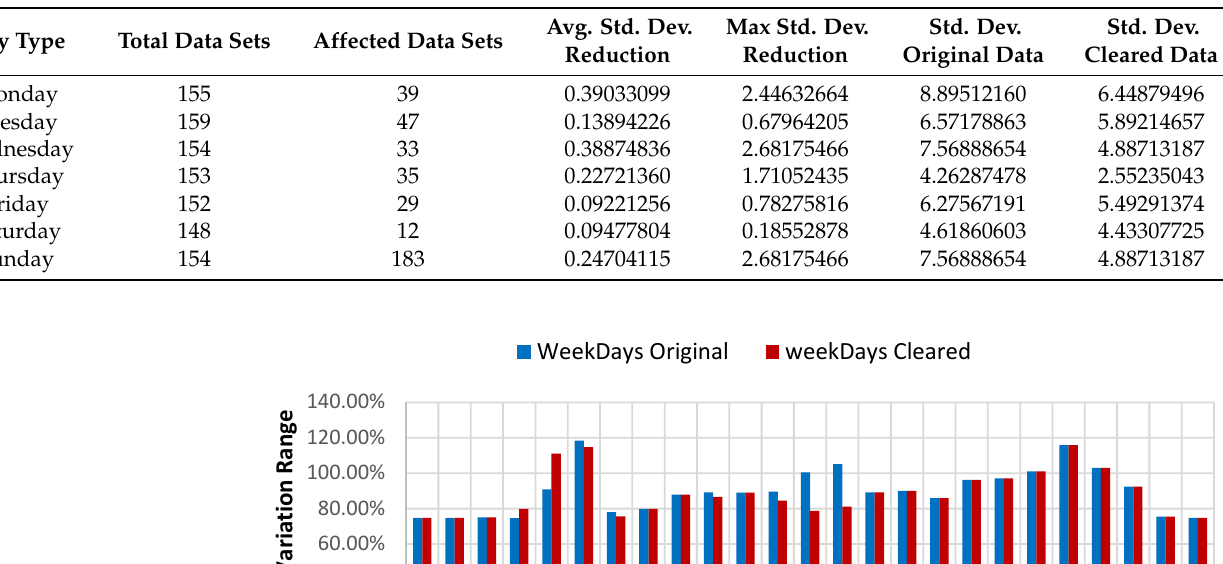
Table 12. Full year baseline for original and cleared data sets.